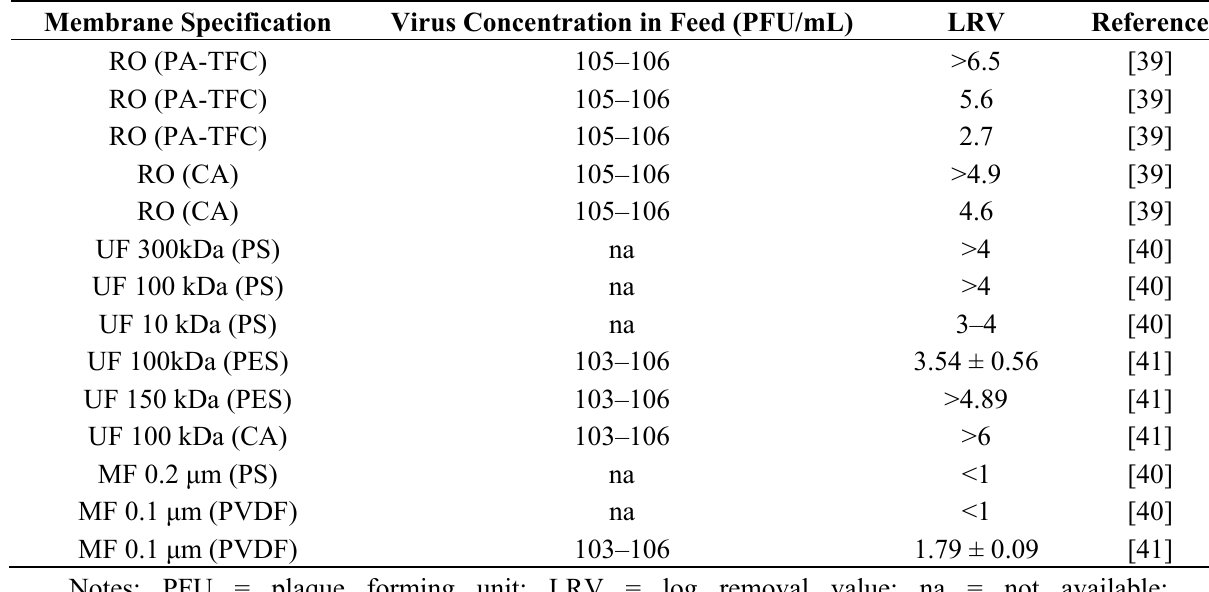
Table 1. MS2 phage removal by different membranes from spiked deionized